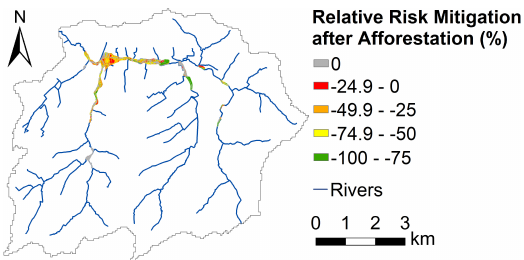
Figure 10. Relative flood risk mitigation (%) in the Maarkebeek catchment after afforesting the 750 highest-ranked pixels in this land use change scenario.